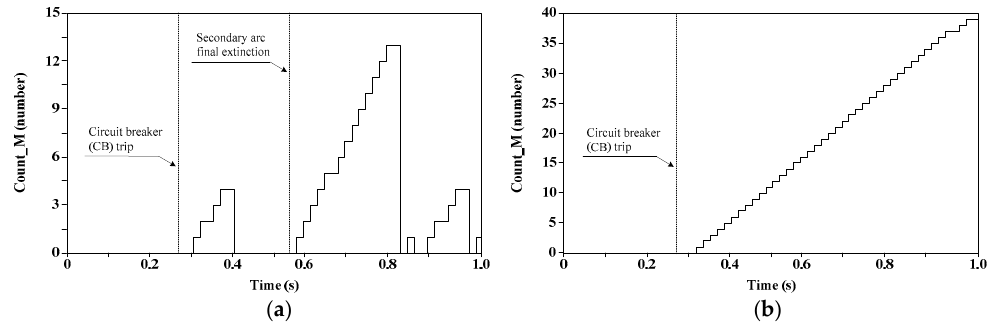
Figure 9. Results of Count_M for transient and permanent faults: ( a ) transient; ( b ) permanent.